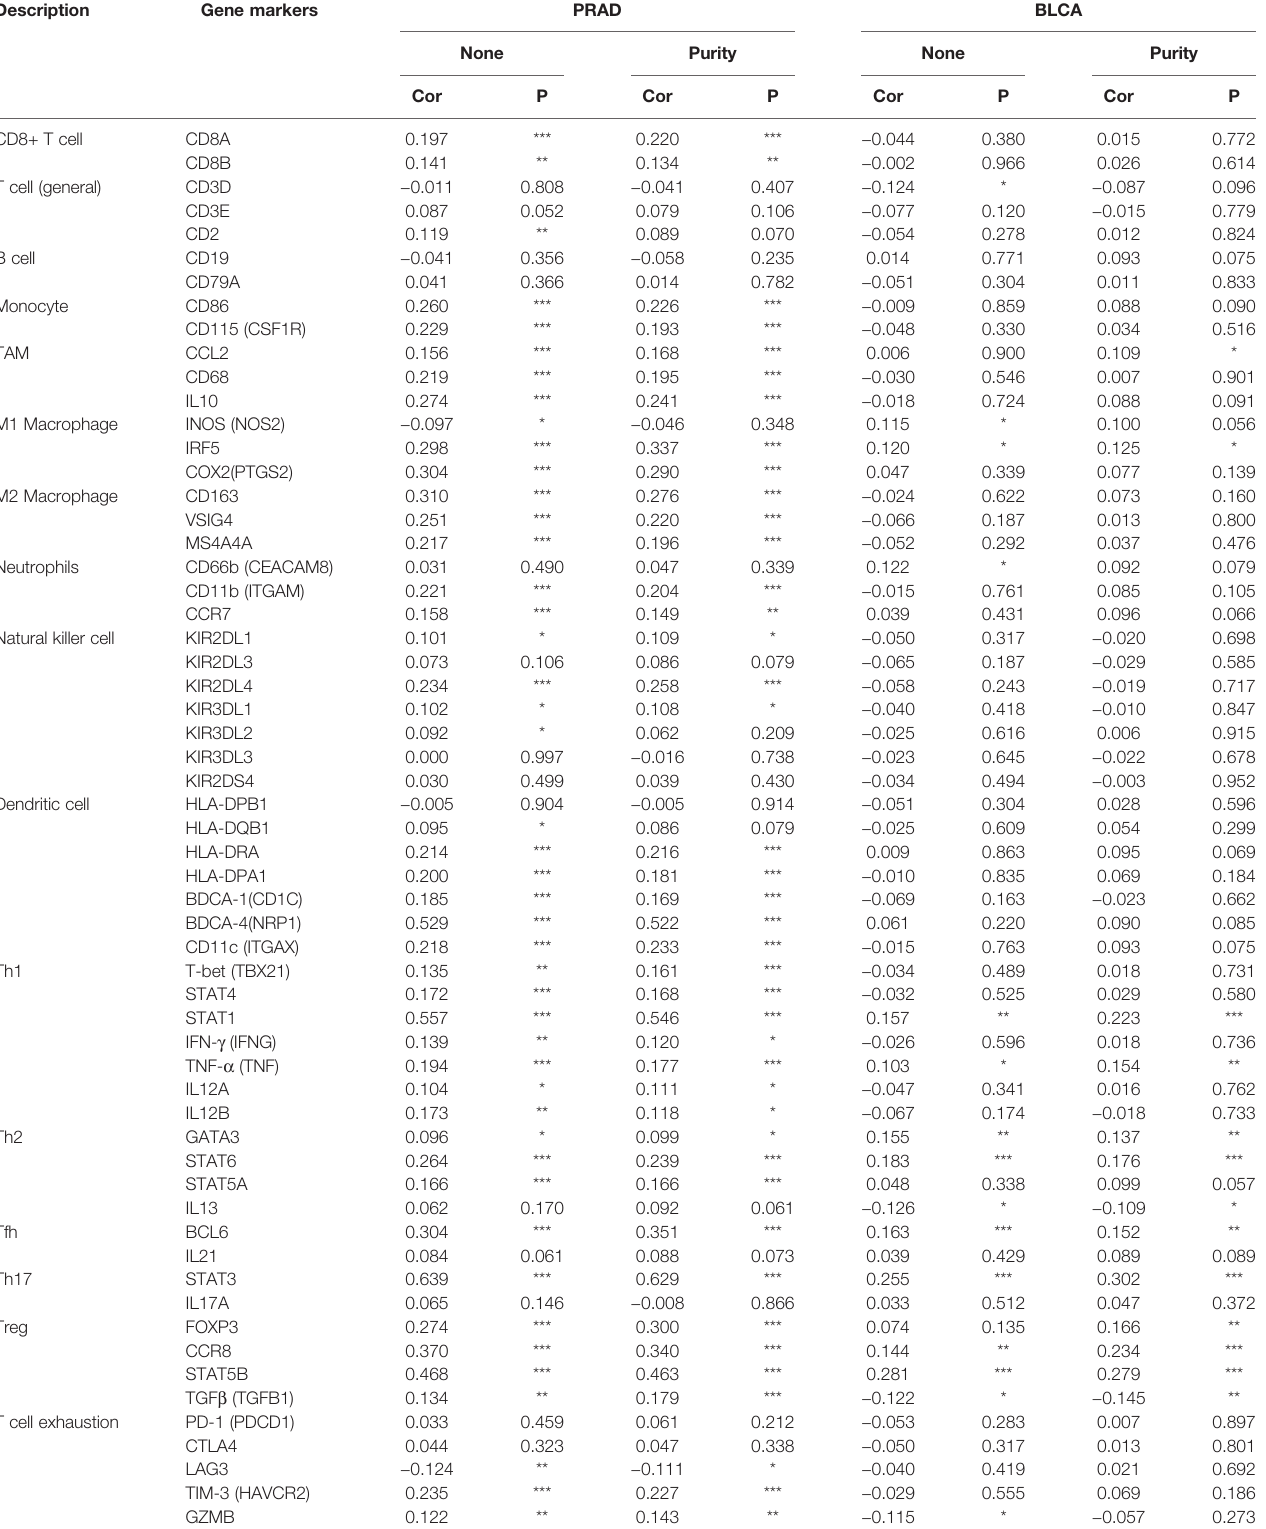
TABLE 1 | Correlation between YTHDF1 and relate genes and markers of immune cells analyzed by TIMER.